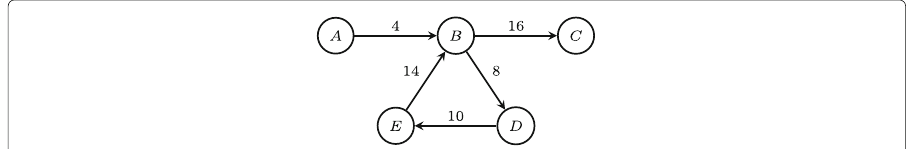
Fig. 1 A temporal graph (with time-labeled arcs called time-arcs) with maximum waiting time four in which the only temporal walk from A to C visits B twice